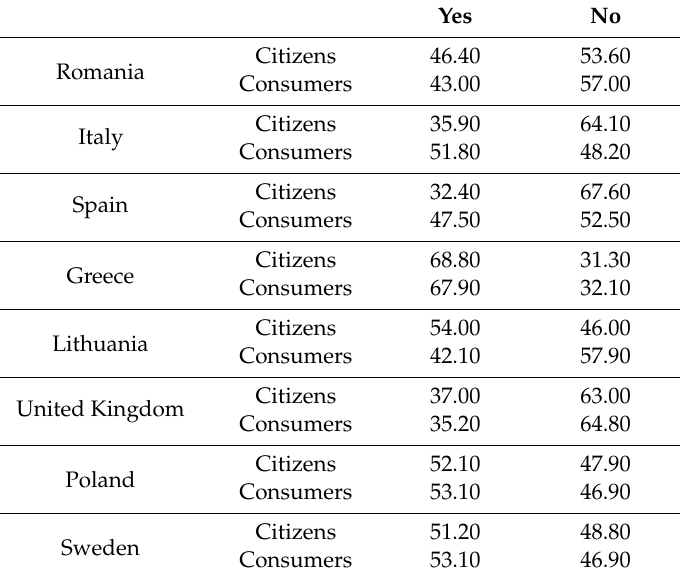
Table 4. Should regulation be more restrictive across countries and respondent